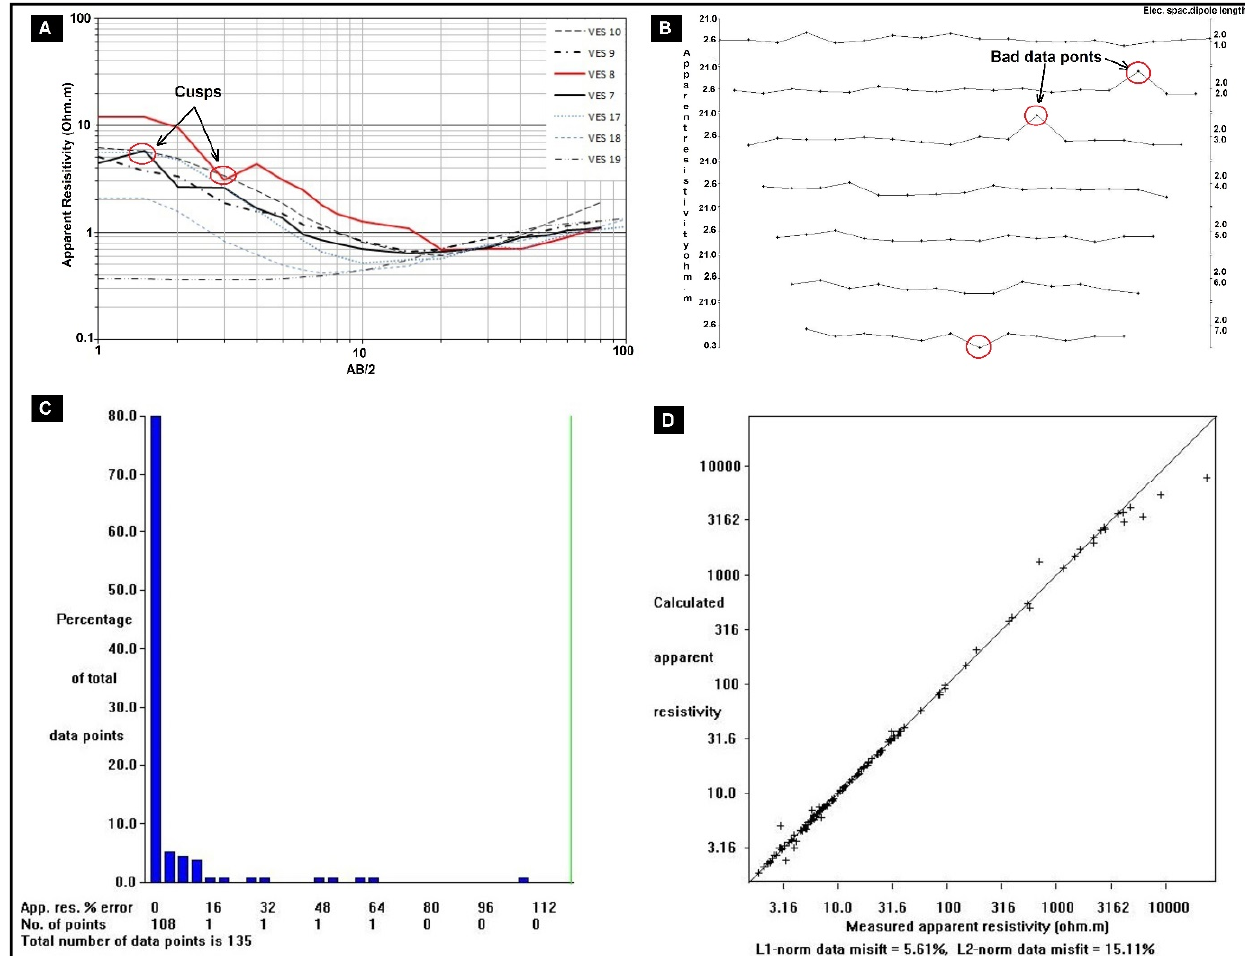
Figure 4. Examples of the measured resistivity data: (A) resistivity sounding points plotted on a bilogarithmic paper; (B) outliers in the 2D ERT profile; and (C,D) statistical plots of the misfit between the observed and calculated apparent resistivity values in the form of a bar chart and a scatterplot, respectively.